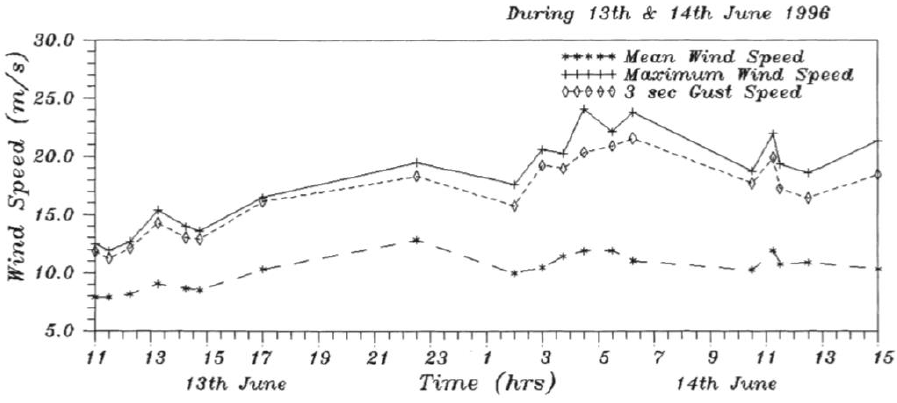
Figure 8. Mean and maximum wind speeds during cyclone [13].